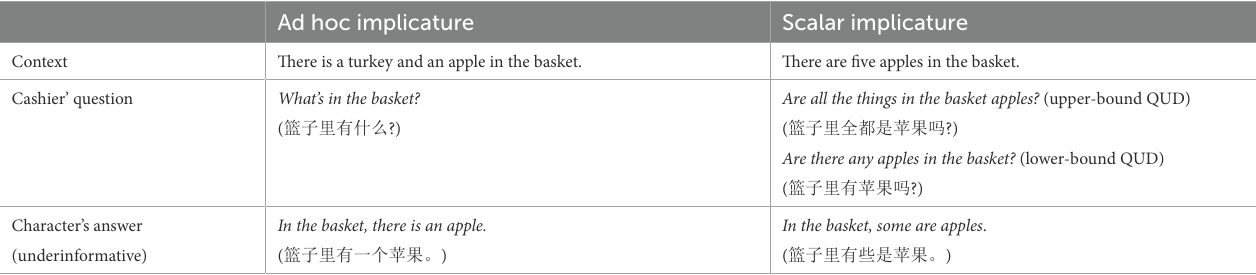
TABLE 1 Examples of target underinformative stimuli of ad hoc and scalar implicature. Ad hoc